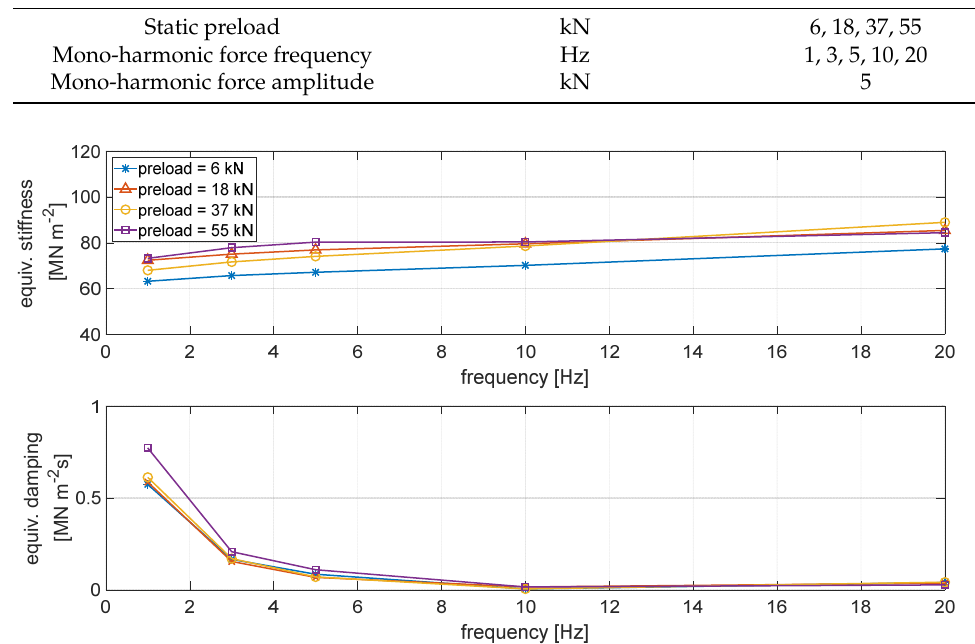
Figure 3. Equivalent stiffness ( upper plot) and viscous damping ( lower plot) of unit length of the elastomeric material of the ERS in function of frequency and preload.